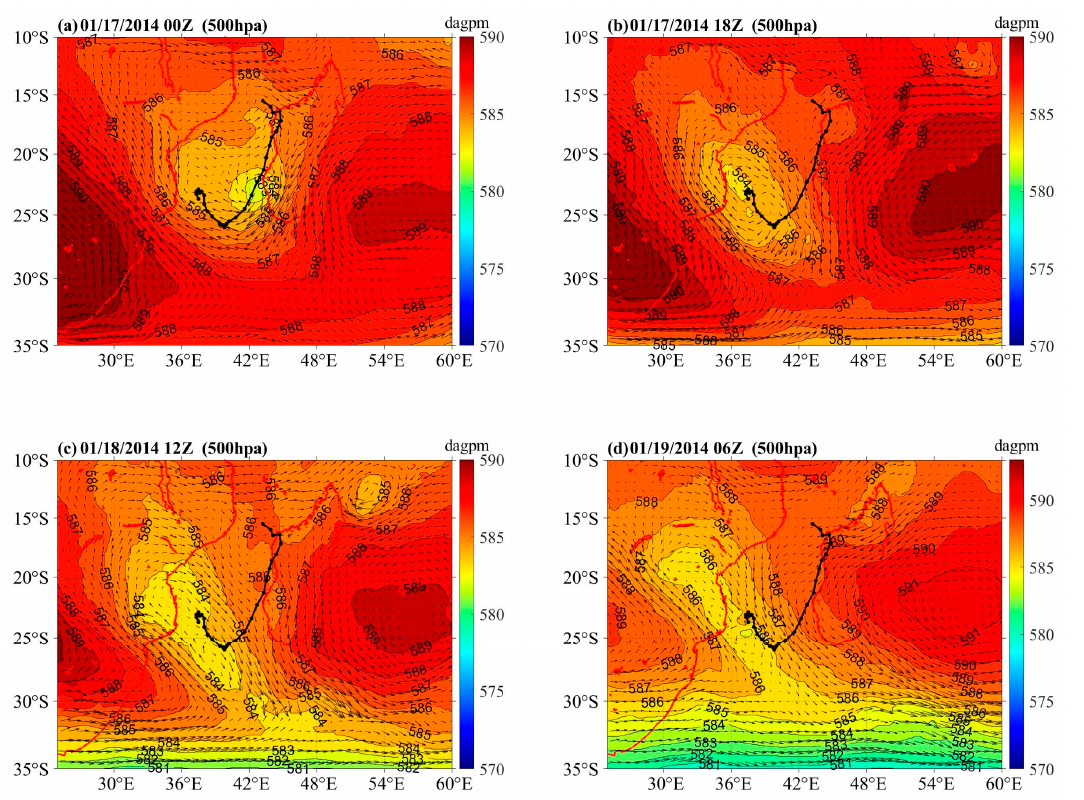
Figure 7. The distribution of geopotential height and wind field at 500 hPa from 00Z on 17 January to 06Z on 19 January 2014.